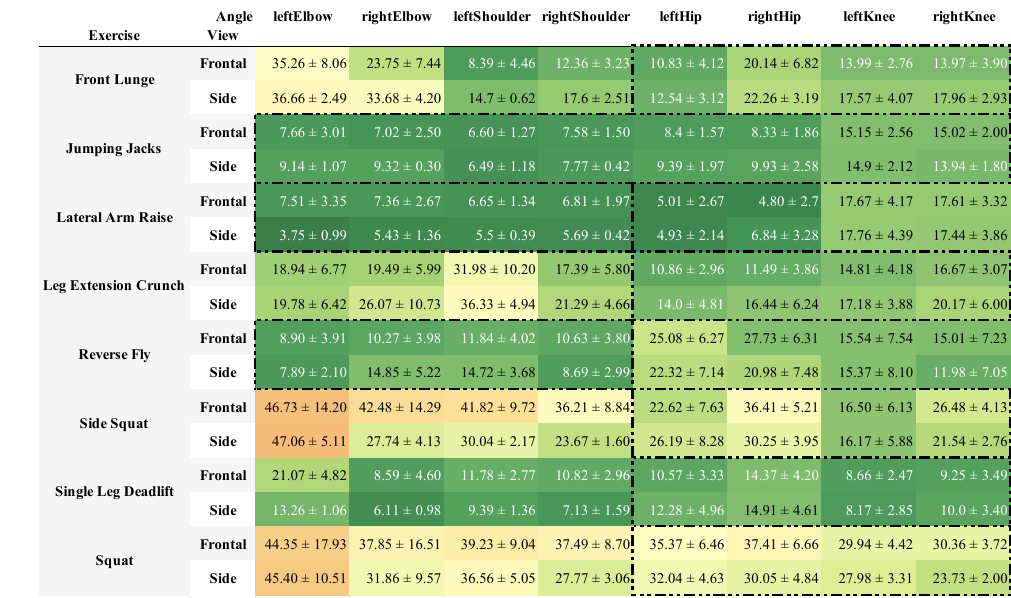
Figure 4. Pivot Table of the weighted Mean Absolute Error (wMAE) in degrees distributed over the eight exercises and the eight tracked angles, each measured from the two iPad perspectives Frontal and Side . The dashed boxes indicate which joints were specifically targeted by the respective exercise. The heatmap visualizes the performance of the individual joints per exercise, with darker green color referring to a lower error rate and darker orange color referring to higher error rates.